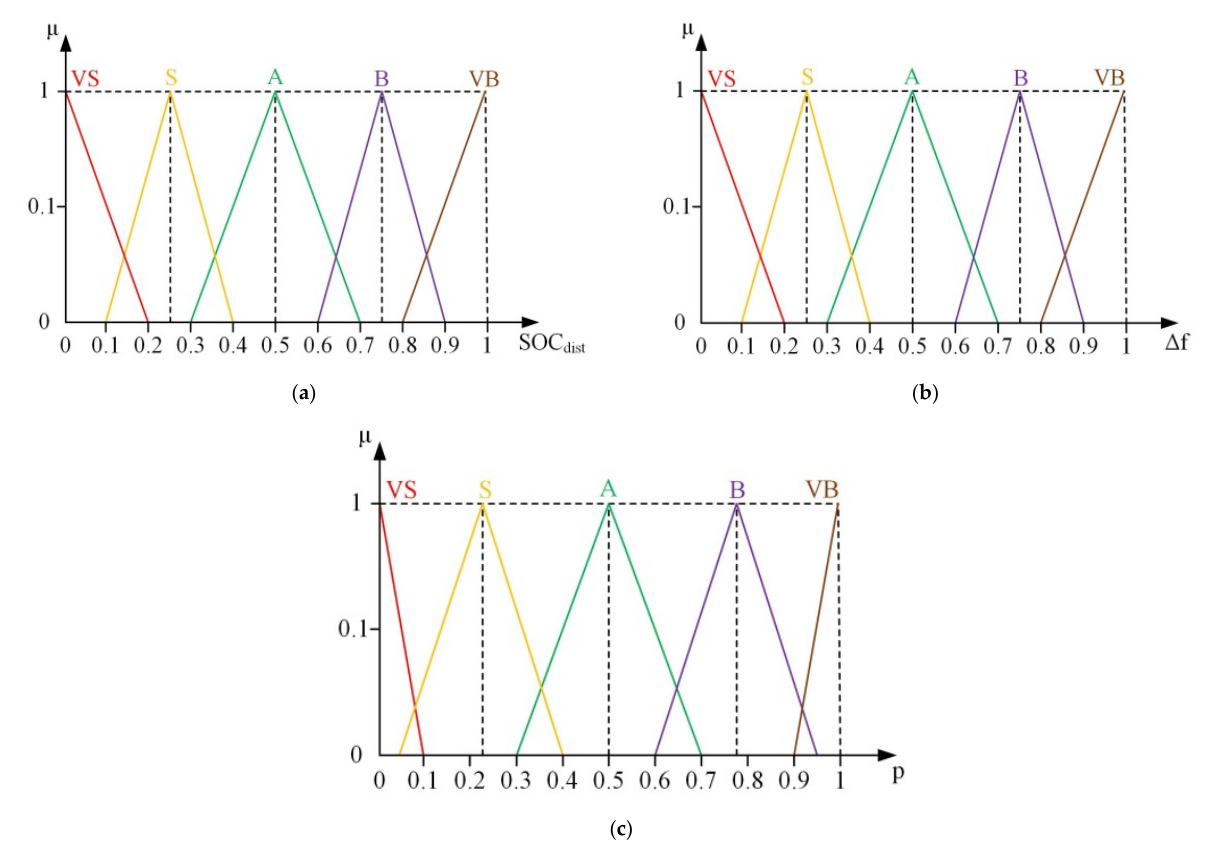
Figure 3. Membership functions of the fuzzy variables: ( a ) SOC dist ; ( b ) frequency deviation from 50 Hz; ( c ) power change coefficient p .